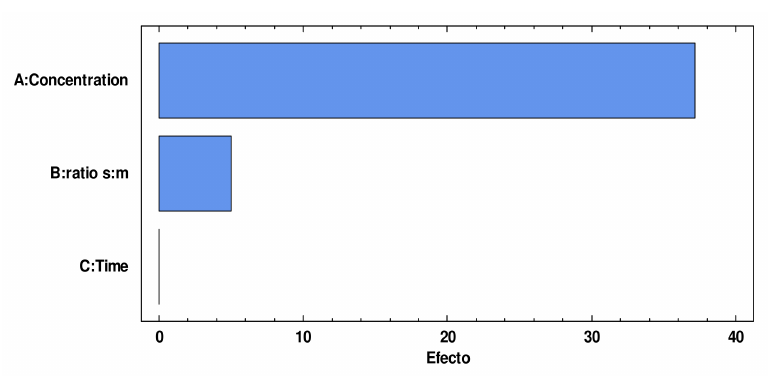
Figure 5. Standardized Pareto